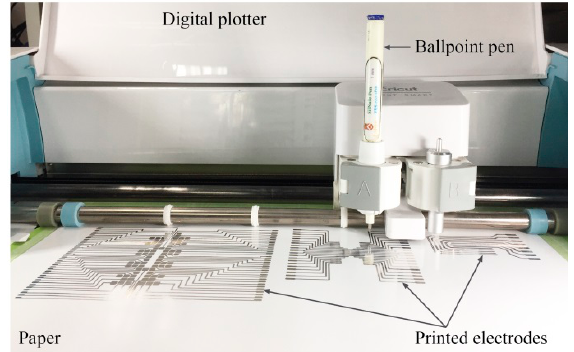
Figure 1. Printing setup for patterning electrode arrays on paper for the fabrication of a digital microfluidic (DMF) chip by using a ballpoint pen and a digital plotter.